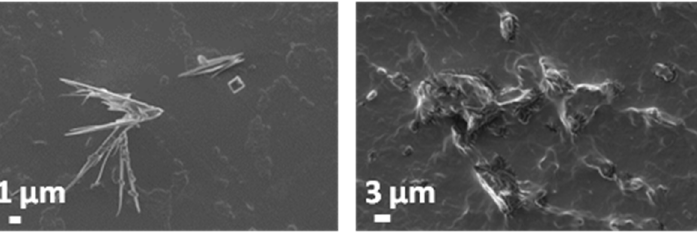
Figure 19. FESEM of ZnO@PLA sample after 21 days in artificial urine.